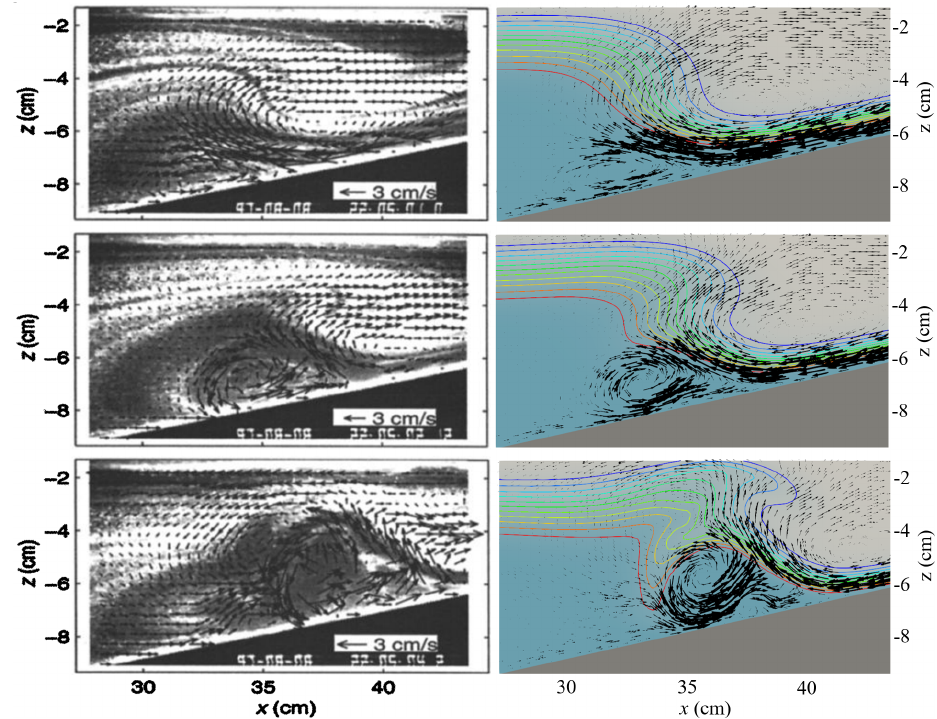
Figure 14. Comparison of the velocity field between the experimental observation results in Michallet and Ivey (1999) (left) and numerical simulation results (right).